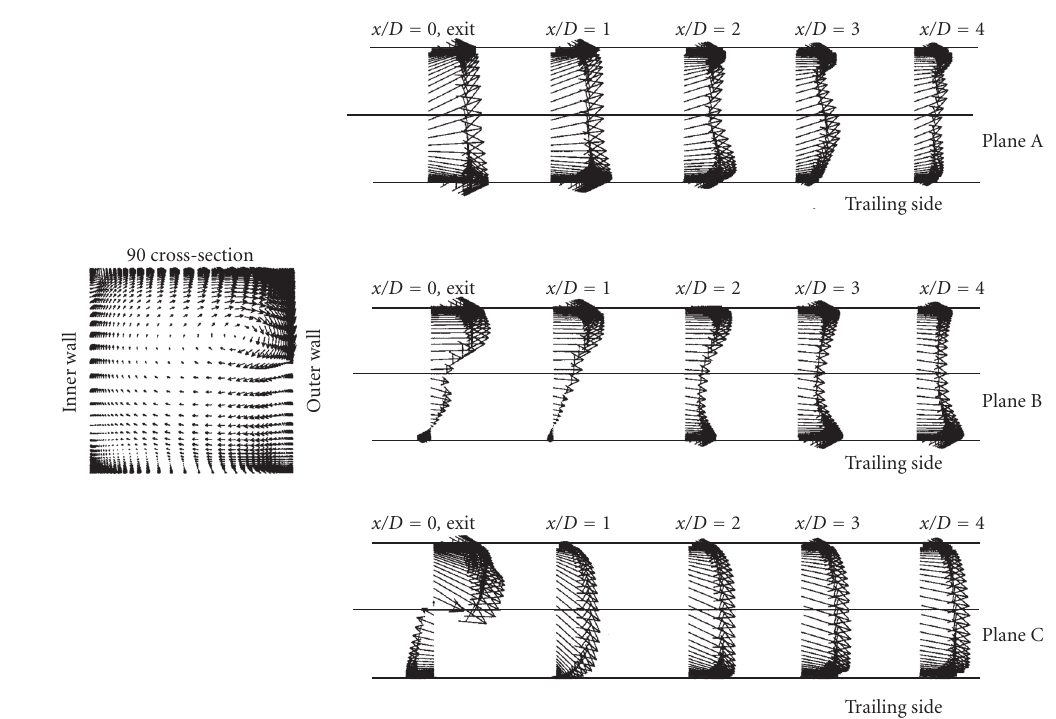
Figure 3: Predicted flow development within and downstream of rotating bend, using the low-Re DSM.